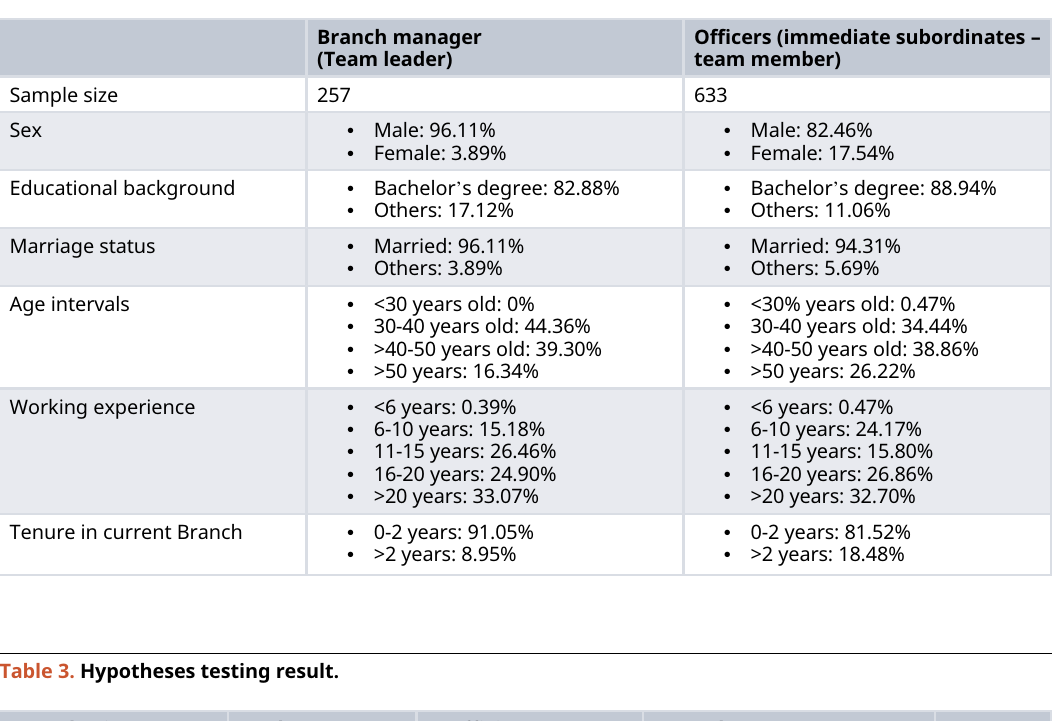
Table 2. Respondent